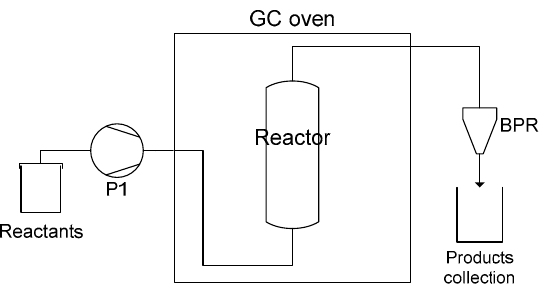
Figure 5. Experimental setup used for the continuous-flow acetalization of glycerol with acetone and 2-butanone.